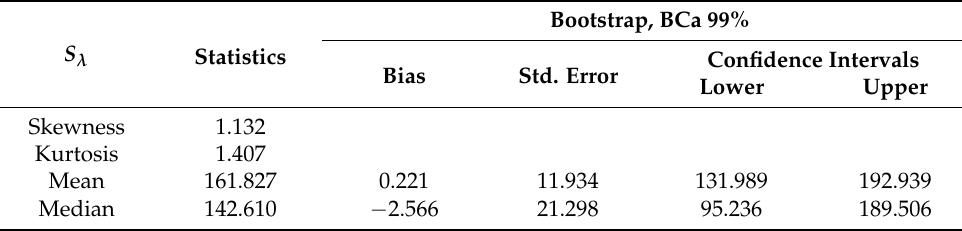
Table 6. Inferential statistics results of derived S λ for M90 decadal dataset at α = 0.01.